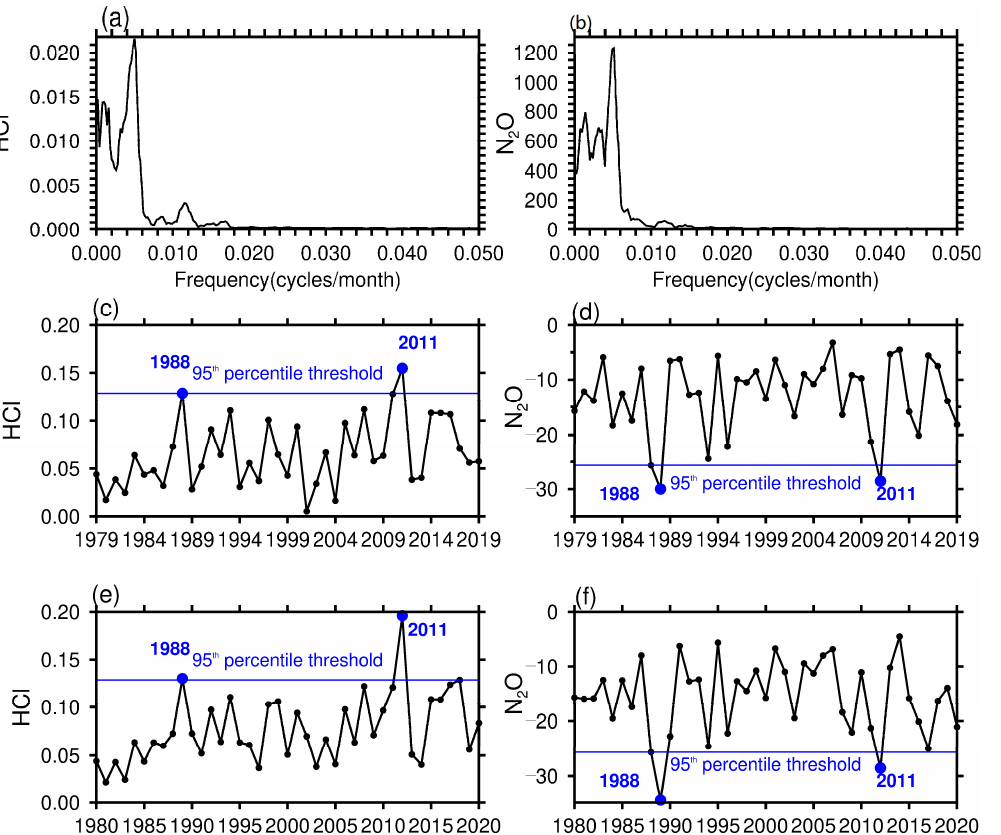
Figure 2. ( a , b ) The spectrum of ( a ) HCl and ( b ) N 2 O anomalies from 1979 to 2020 based on the SLIMCAT model simulation. ( c – f ) Variations in ( c , e ) HCl and ( d , f ) N 2 O gradient based on the SLIMCAT model simulation. The HCl (N 2 O) gradient was calculated using the maximum value of HCl (minimum value of N 2 O) in a year minus the minimum (maximum) value in the past ( c , d ) 10 months and ( e , f ) 24 months. The blue dots represent the years 1988 and 2011.